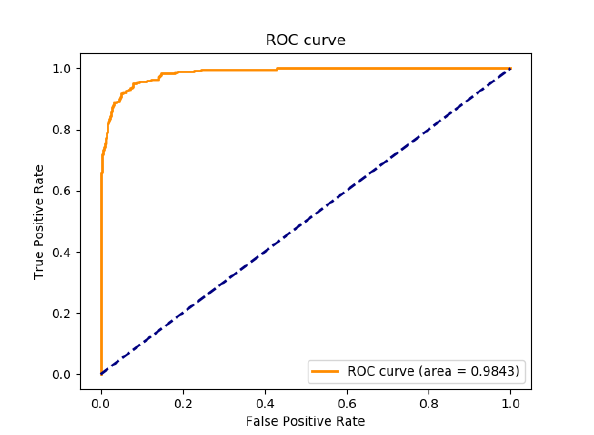
Figure 7. ROC curve